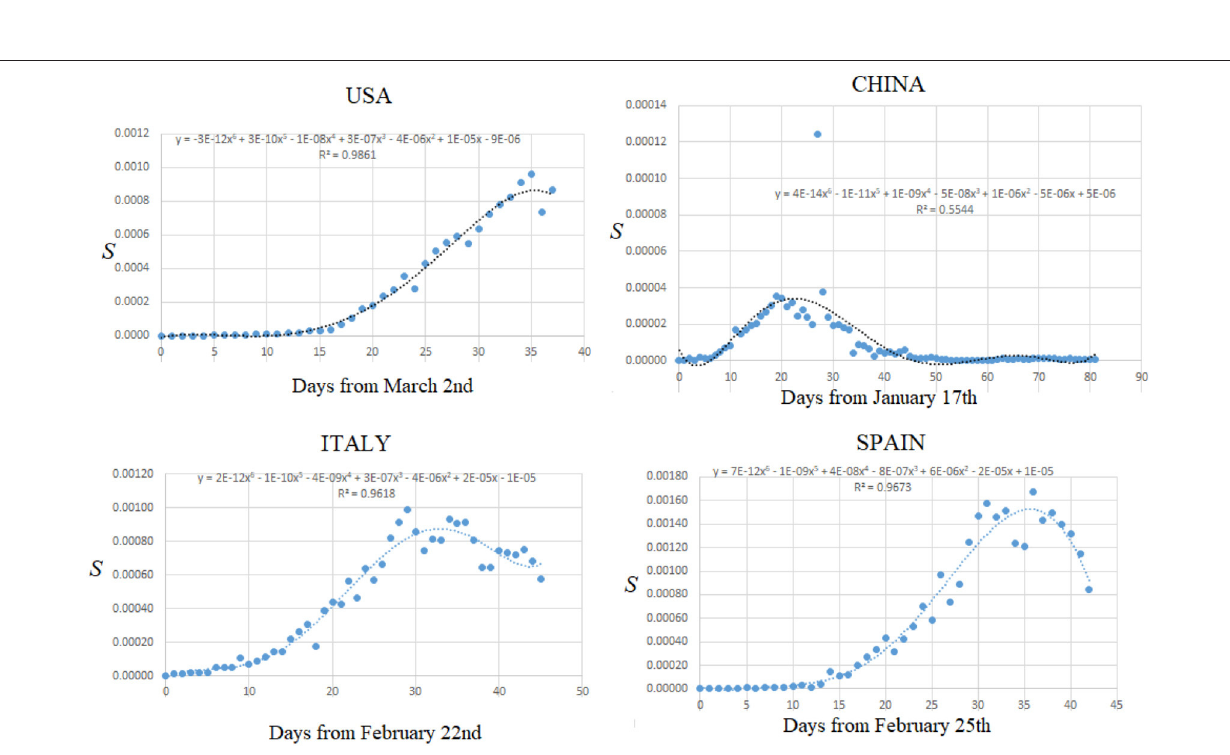
Frontiers in Physics | www.frontiersin.org